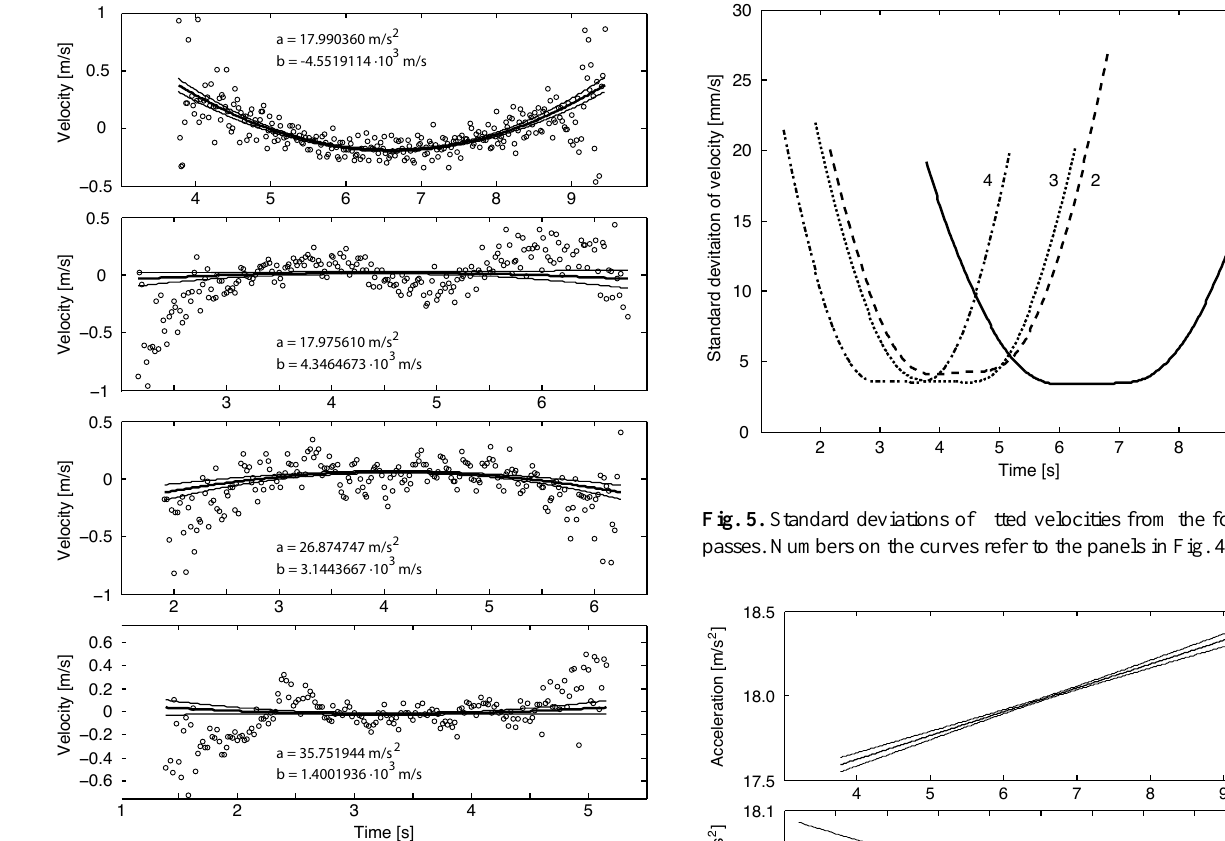
Fig. 6. The results indicate that, indeed, the variation of ac- celeration is important within the interval of a few